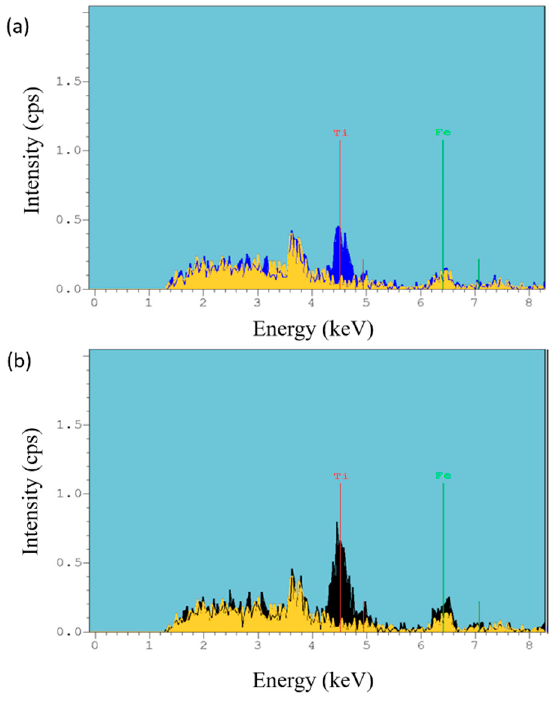
Figure 9. Comparative X-ray fluorescence of the electrospun coatings for PAA + β -CD versus PAA + β -CD + TiO 2 ( a ) and for PAA + β -CD versus PAA + β -CD + TiO 2 + Fe 2 O 3 ( b